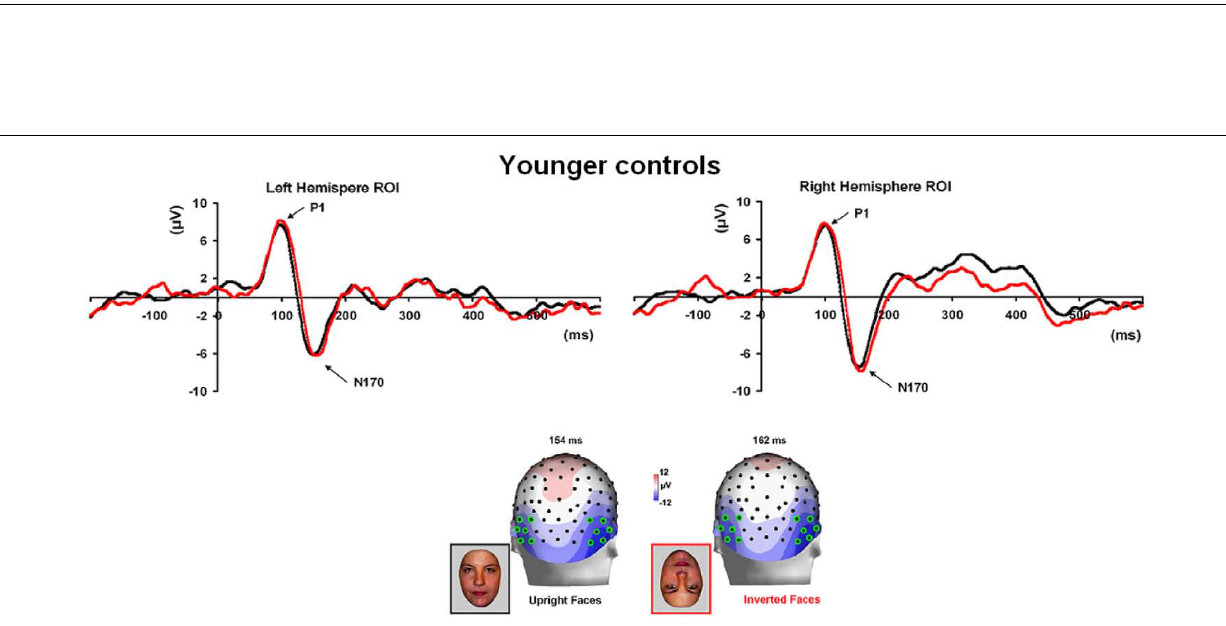
FIGUREA4 |Waveforms and topographies of the N170 component of young participants in response to both upright and inverted faces.